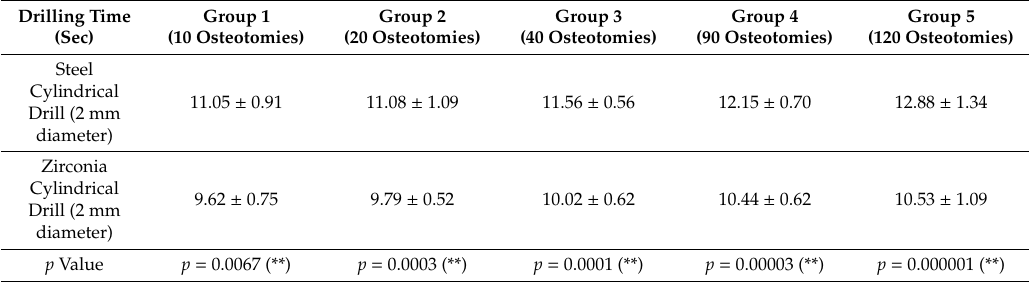
Table 3. Summary of the drilling time (in seconds) preparation calculated for zirconia and steel groups (mean ± standard